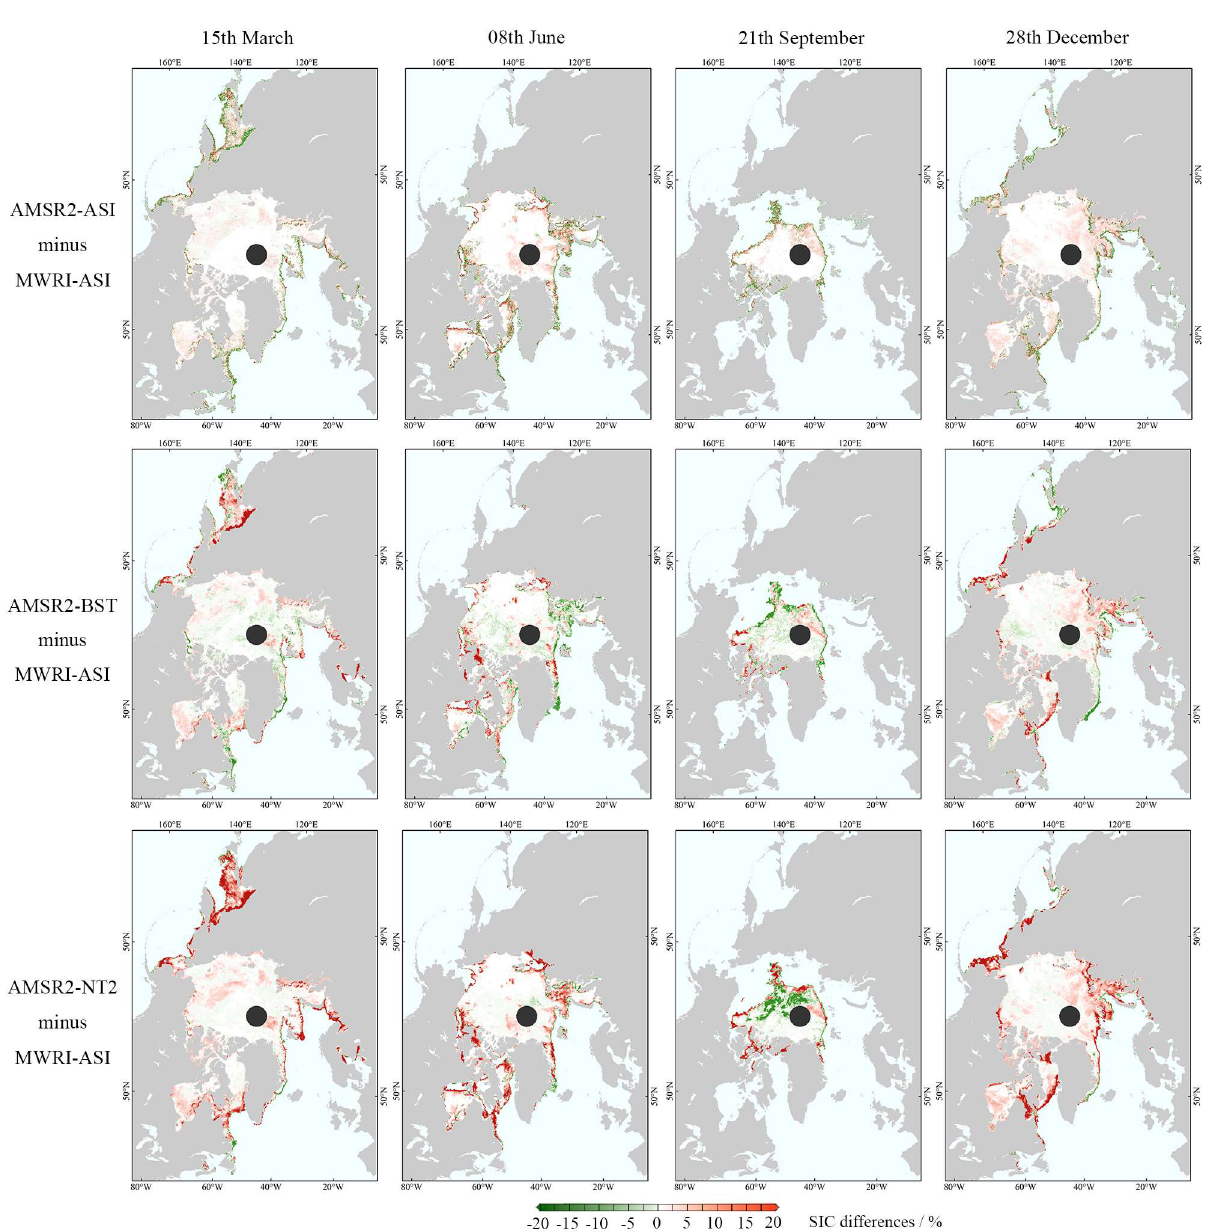
Figure 4. Differences maps of SIC on 15 th March, 08 th June, 21 th September, and 28 th December 2018 of AMSR2-ASI minus MWRI- ASI (top), AMSR2-BST minus MWRI-ASI (middle) and AMSR2-NT2 minus MWRI-ASI (bottom). AMSR2-NT2 curves for sea ice area during winter period (see Figure 5d). For both sea ice extent and sea ice area, the biases are negative between AMSR2-ASI and MWRI-ASI, indicating that MWRI-ASI gives larger sea ice extent and sea ice area than AMSR2-ASI. For sea ice extent, AMSR2-BST shows the lowest absolute biases with MWRI-ASI and MWRI-NT2 with the values of −0.29 × 10 6 km 2 and −0.39 × 10 6 km 2 , respectively. There are the lowest absolute biases between AMSR2-NT2 and two MWRI sea ice area, with the values of −0.13 × 10 6 km 2 and −0.44 × 10 6 km 2 for MWRI-ASI and MWRI-NT2, respectively. Compared to sea ice extent and sea ice area derived from three AMSR2 SIC products, the biases of MWRI-ASI are around 0.10 × 10 6 km 2 and 0.30 × 10 6 km 2 lower for sea ice extent and sea ice area than MWRI-NT2,